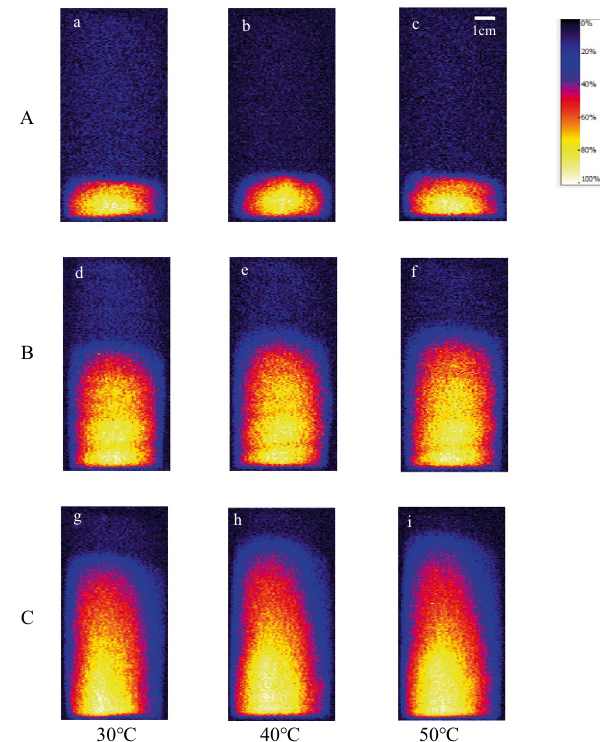
Figure 7. Liquid capillary rise distribution with different temperatures (160